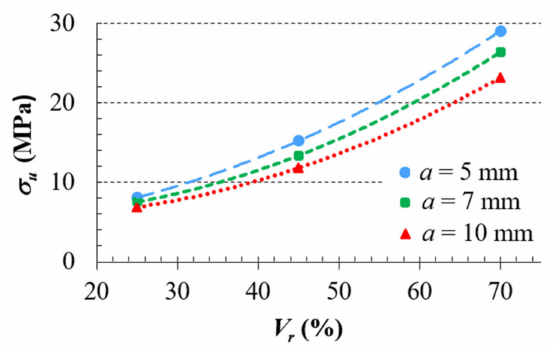
Figure 10. Dependencies of ultimate strength limit on volume ratio V r .